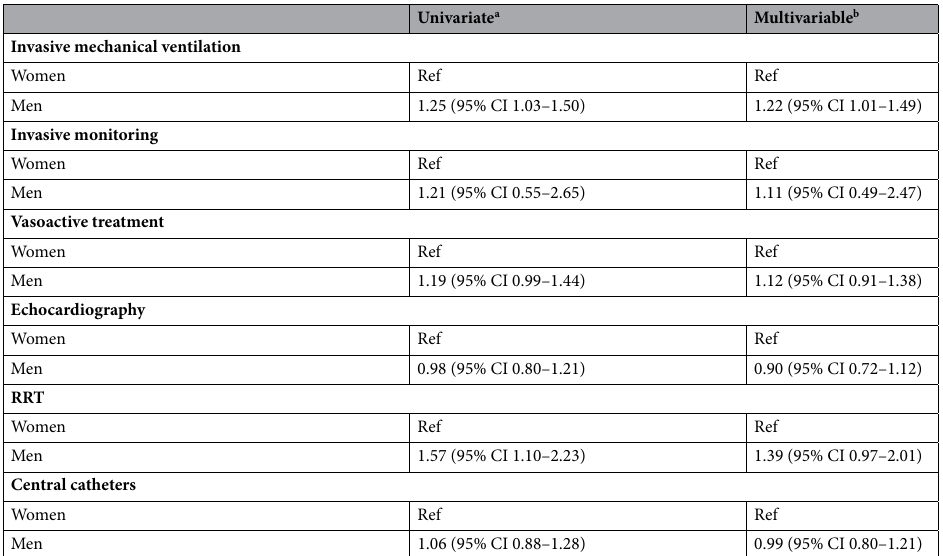
Table 5. Univariate and multivariate logistic regression analyses on patients admitted with respiratory disease, exploring differences in the use of invasive mechanical ventilation, invasive monitoring, vasoactive treatment, echocardiography, RRT and placement of central catheters, based on the sex of the patient. Data presented as odds ratio and 95% CI. a 1799 and 1769 patients are included in univariate analyses and multivariable analyses respectively. b Adjusted for Age, Estimated mortality risk and Charlson Co-morbidity index. RRT renal replacement